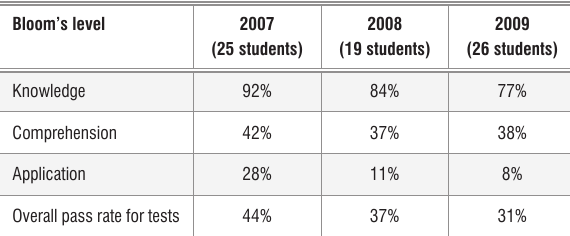
Table 4: Pass rates for the pre-test for each cohort